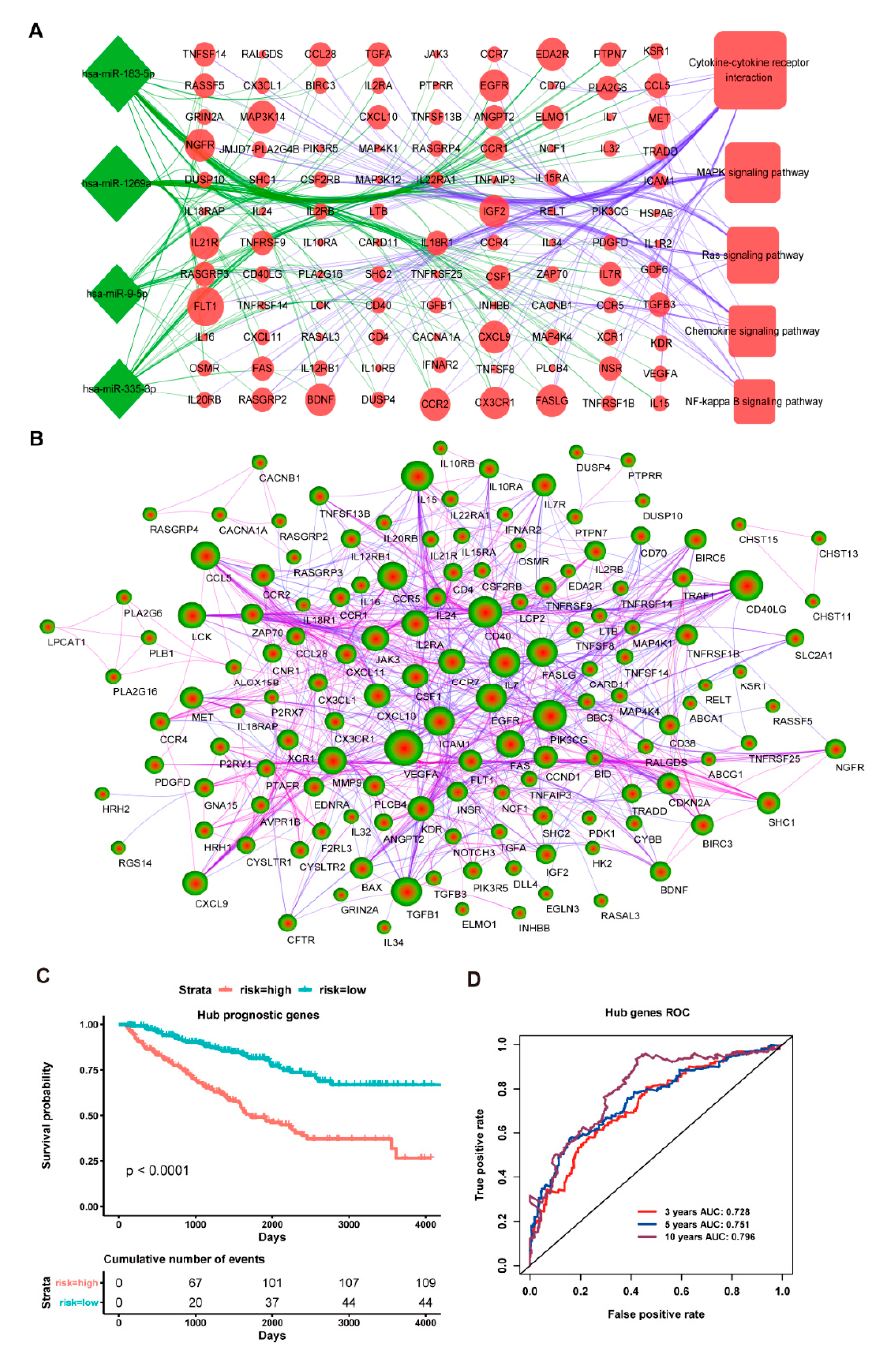
Figure 4. The cancer signaling pathway and protein network analysis of these up-regulated targets and the prognostic model of the ten-hub gene signature. ( A ): Target genes of four down-regulated miRNAs involve in the network map of cancer-related signaling pathways. The green represents the down-regulated expression and the red represents up-regulated expression; ( B ): Target protein interaction network of four down-regulated miRNAs. The blue line means low credibility and the purple line means high credibility; ( C ): Overall survival curves for high-risk and low-risk groups based on the ten-hub gene model; and, ( D ): ROC curves for high-risk and low-risk based on the ten-hub gene model.